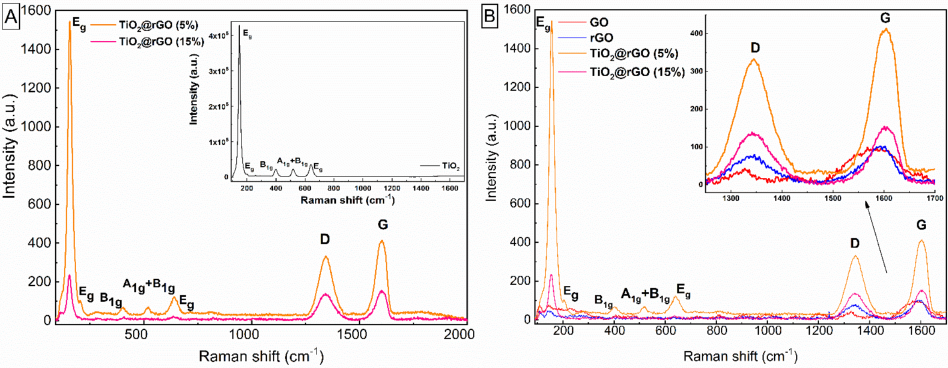
Figure 2. Raman spectra of ( A ) the respective nanocomposites, (inset shows TiO 2 calcinated at 300 ◦ C); and ( B ) GO, rGO, and the respective nanocomposites. The inset shows the characteristic D and G bands of graphene-based materials.